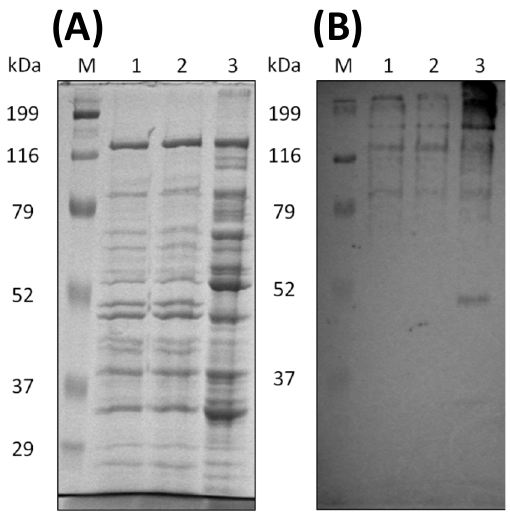
Figure 6. Analyses of the culture supernatants of C. cellulovorans with cellobiose and untreated or treated sugarcane bagasse. ( A ) SDS-PAGE and ( B ) Western blot analysis using an anti-CbpA antibody (1:2000 dilution). Lane M, molecular mass marker; lane 1, supernatant cultivated with 1% pretreated sugarcane bagasse, lane 2: supernatant cultivated with 1% untreated sugarcane bagasse; lane 3, supernatant cultivated with 0.5%